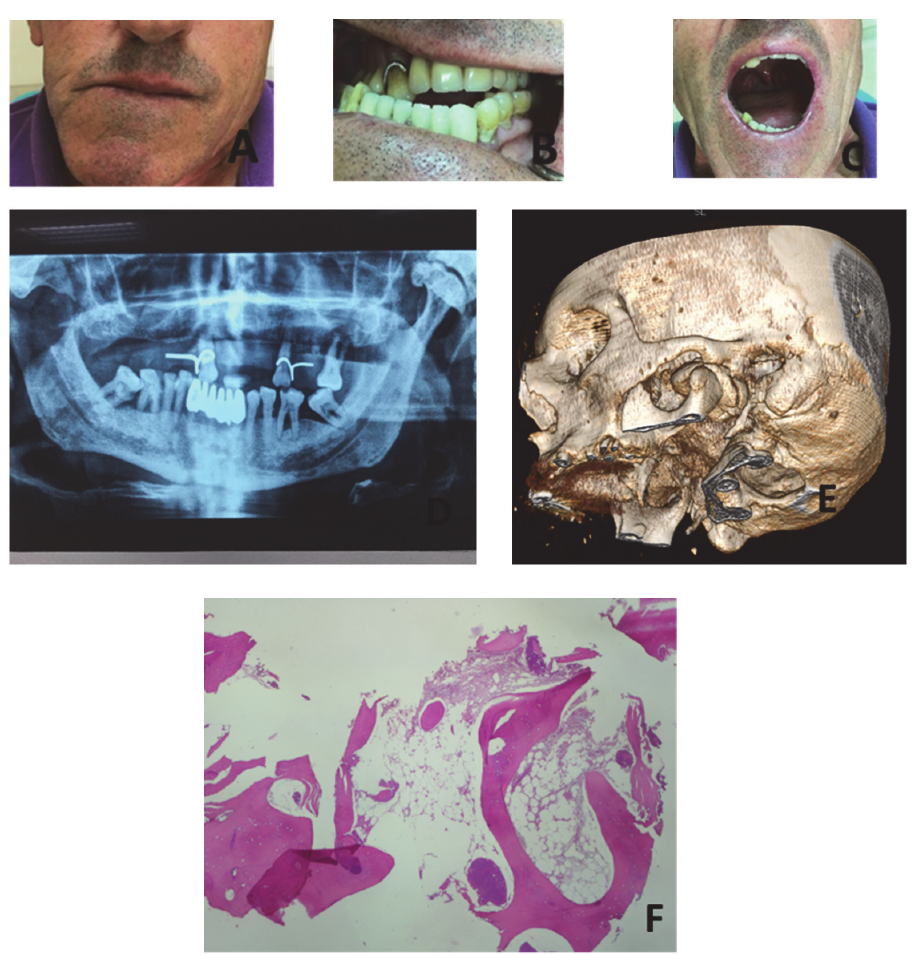
Figure 3. ( A ) Asymmetry of the lower third of the face; ( B ) Intense laterognathism of the mandible; ( C ) Wide mouth opening; ( D ) Panoramic X-ray showing the presence of osteoma of the left